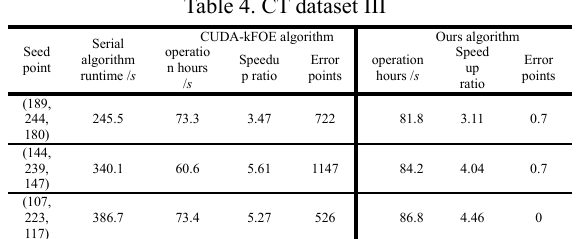
Figure 7. Comparison of results before and after refinement of three datasets Table 3. CT dataset II Table 4. CT dataset III